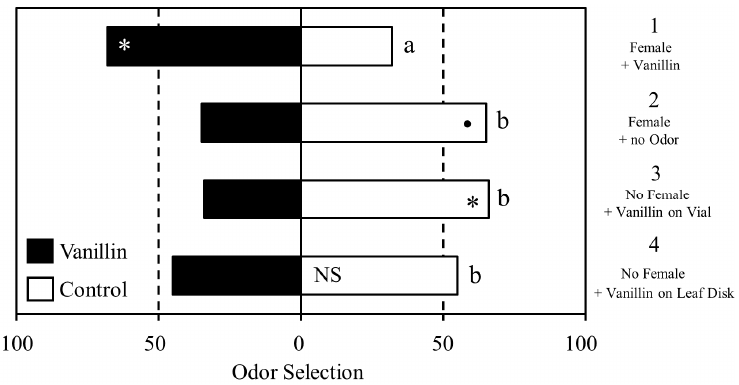
Figure 2. Learned response to vanillin depending on the conditioning environment. Significant within-group differences in selection the of vanillin (grey bars) or the unscented control arm (white bars) are indicated by asterisks; • <0.1, * ≤ 0.05. Significant differences in overall selection pattern between treatment groups are indicated by different letters.